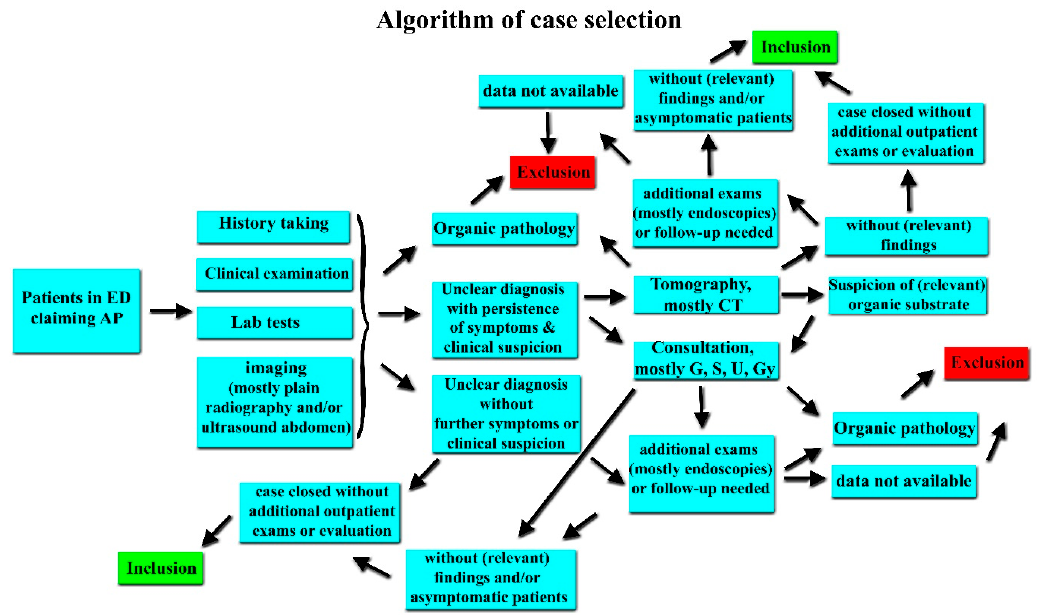
Figure 2. Schematic representation of the chosen algorithm for case selection. AP; abdominal pain, ED; emergency department, CT; computer tomography, G; gastroenterologist, Gy; gynecologist, S; surgeon, U; urologist/nephrologist.